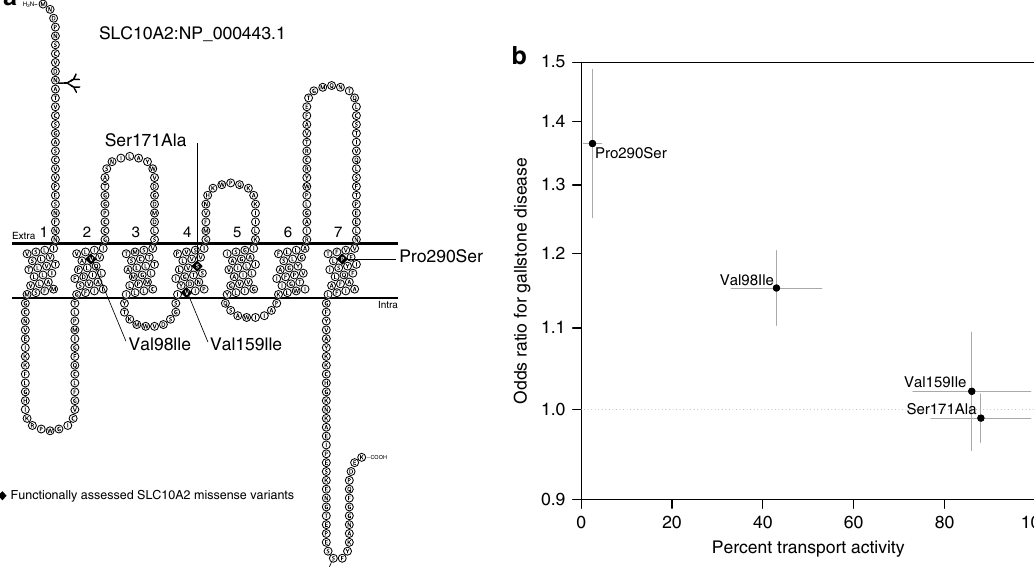
Fig. 3 SLC10A2 transport activity and gallstone risk. a Schematic illustration of the topology of the SLC10A2 protein showing the localization of the functionally assessed missense variants Pro290Ser, Val98Ile, Val159Ile, and Ser171Ala (from PMID: 19823678). b A scatter plot showing four SLC10A2 missense variants Pro290Ser, Val98Ile, Val159Ile, and Ser171Ala. The x -axis shows the bile acid transport activity (from PMID:21649730) while the y -axis shows the odds ratio for gallstone disease in the Iceland + UK meta-analysis ( N cases = 27,174, N controls =